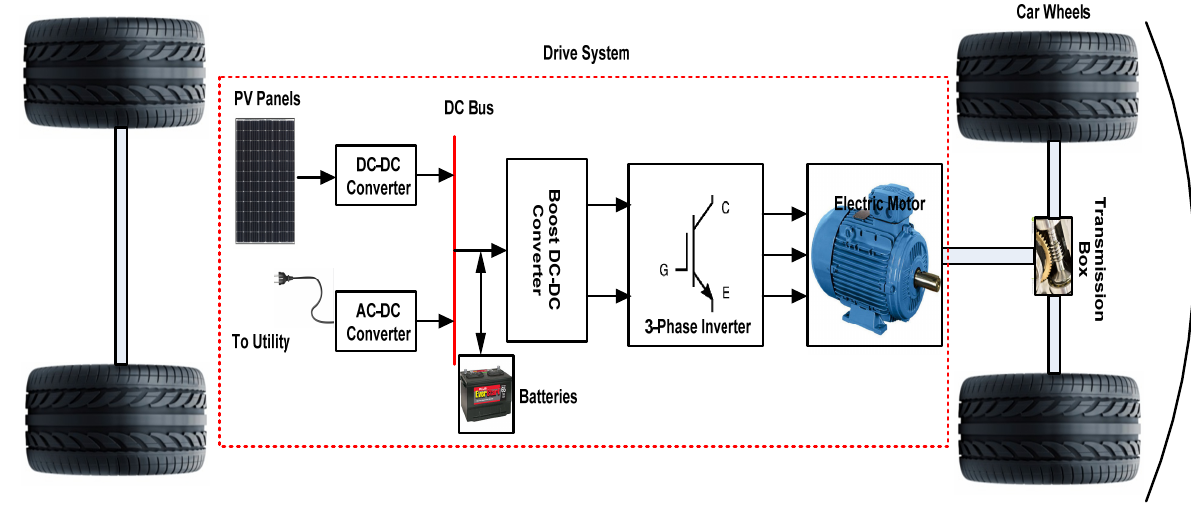
Figure 2. Golf car drive system.